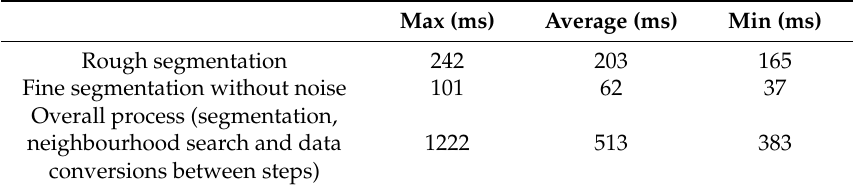
Table 5. Times required for different steps of the hand segmentation process.